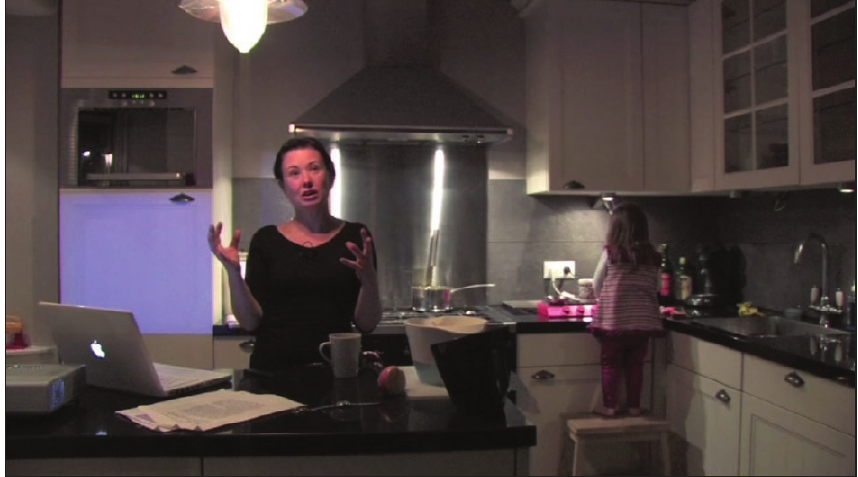
Figure 4: Deirdre Donoghue, Kitchen Lecture: Notes on Gesture , video performance 43’ 26“